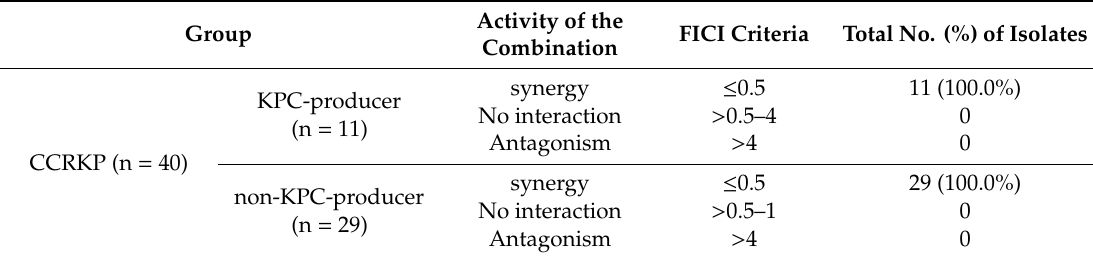
Table 4. In vitro synergistic analysis using the checkerboard method.